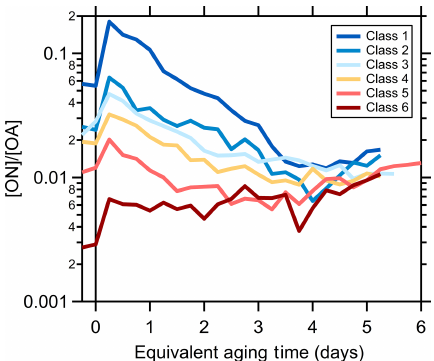
Figure 5. Dependence of the observed organic-nitrate-to-total-OA ratio for each SSA class on the equivalent aging time (assuming [OH] = 1 . 5 × 10 6 moleculescm − 3